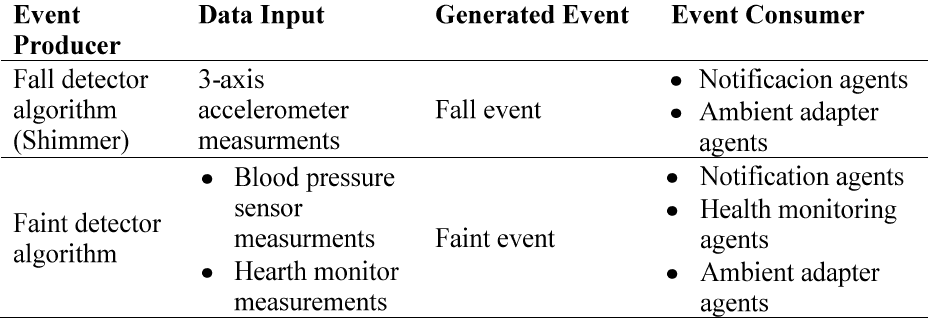
Relationship between event producers and event consumers in the motivation